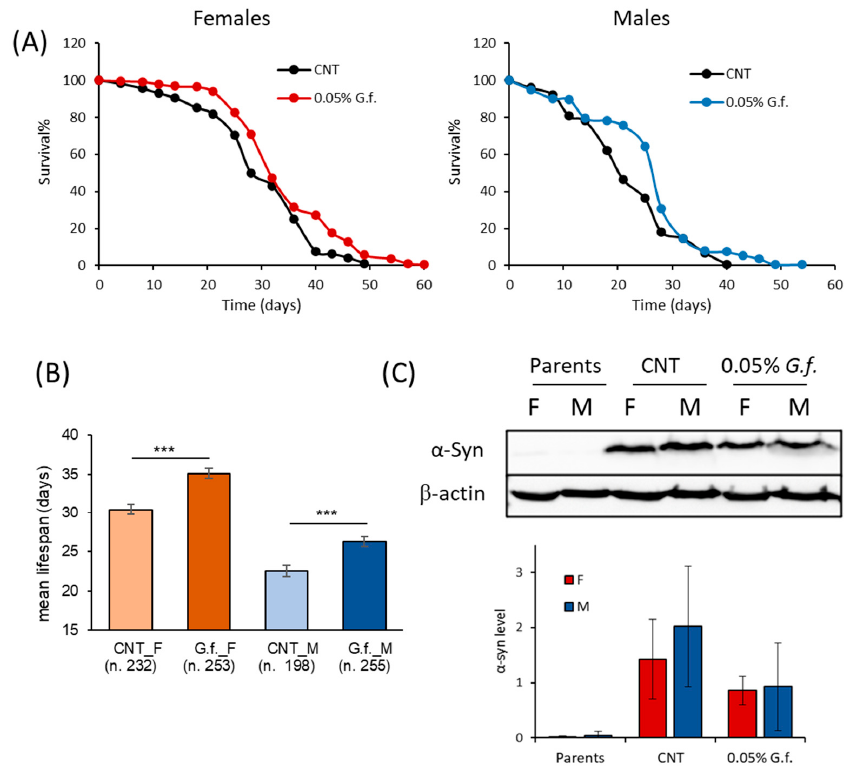
Figure 8. Fungal extract extends the lifespan of adult female and male flies. ( A ) Flies were supple- mented with 0.05% G. frondosa extract lifelong. Data are presented as a percentage of survival of flies as a function of time (in days), evaluated in ten independent measurements for each group of flies by the Kaplan–Meier estimator (OASIS2 software). ( B ) The Log-rank test (OASIS2 software) was used to compare the mean lifespan of both male and female flies. *** p < 0.001 vs the respective CNT. ( C ) Western analysis of α -syn expression in fly brains supplemented or not with 0.05% G. frondosa extract. Representative immunoblot images and histograms of band-normalized OD are shown. Data are presented as mean ± SEM of three independent experiments.